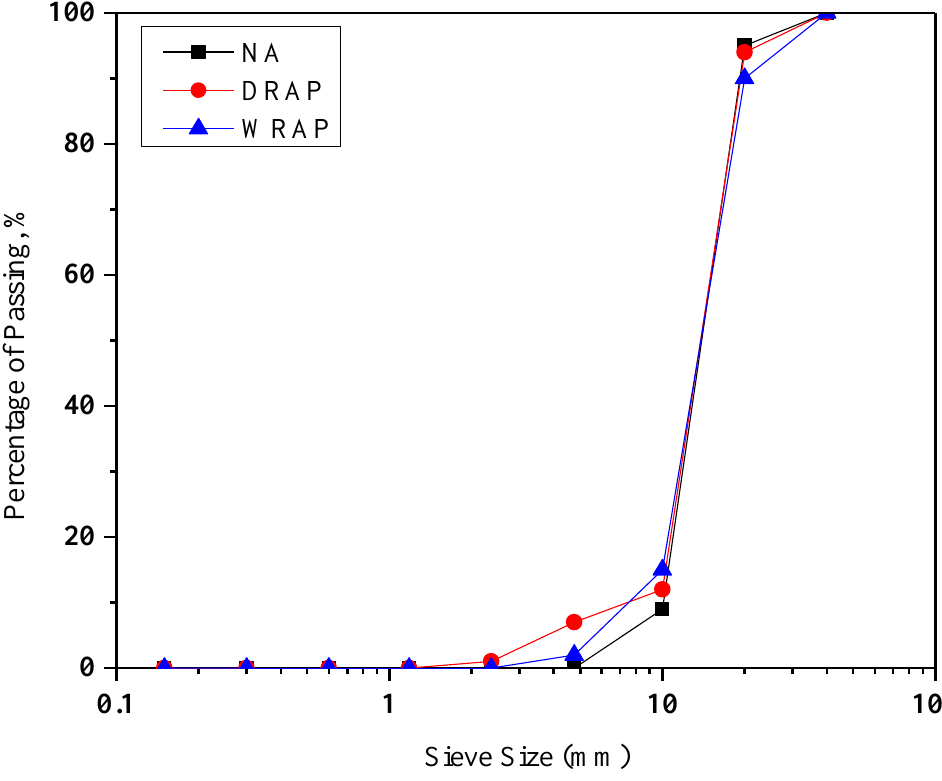
Figure 3. Particle size Distribution analysis of NA, DRAP and WRAP aggregates. Table 3. Mix proportions of ingredients considered in RAP mixes in kg/m 3